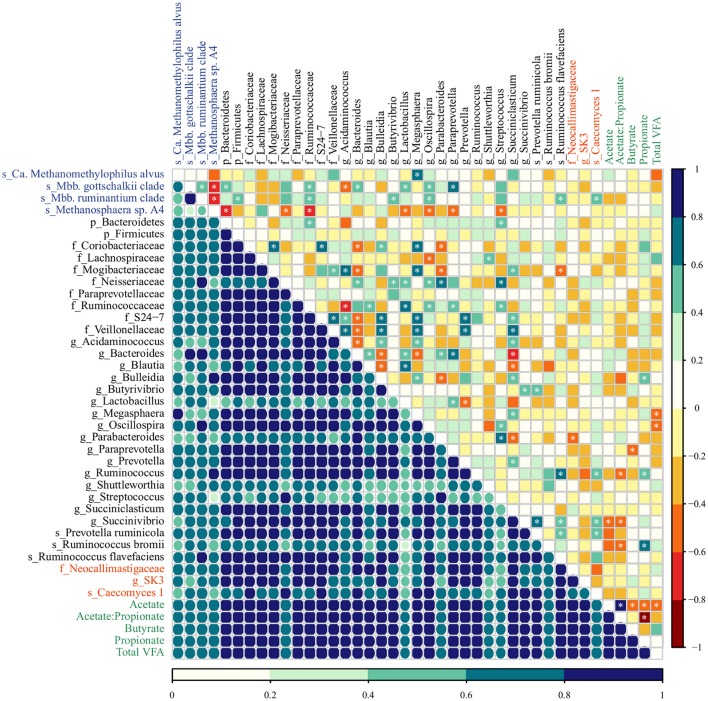
The co-occurrence and correlation among archaeal (blue), bacterial (black), fungal (red) taxa, and molar proportions of volatile fatty acids (green) in the rumen samples of MC-fed calves. The co-occurrence is shown by Dice's index (lower matrix), ranging from 0 to 1, represented by color key (dark blue: high, seagreen: moderate, light blue: low co-occurrence). The correlation is shown by Spearman's rank correlation (upper matrix), ranging from −1 to 1 and represented by color key dark red (perfect negative correlation) to dark blue (perfect positive correlation). The correlations marked with asterisks are significant at a P < 0.05 (Supplementary Table 7).